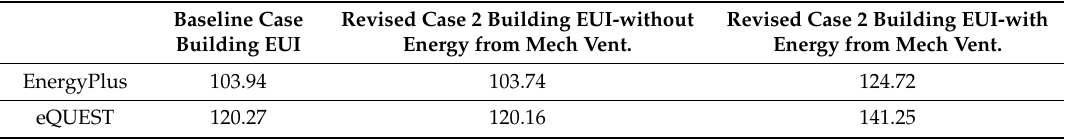
Table 5. Building Level Energy Use Intensity of Revised Cases from EnergyPlus and eQUEST (all figures in kWh / m 2 · year). Table 6. Zonal Energy Use Intensity of Revised Cases from EnergyPlus and eQUEST (all figures in kWh/m 2 ·year).